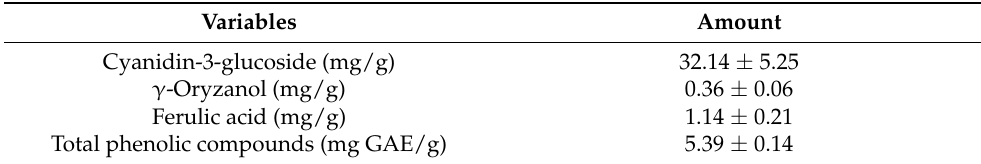
Table 1. Phytochemical profiles of Superjami rice